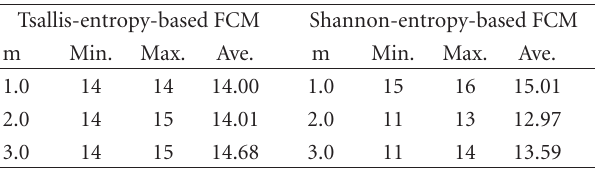
Table 1: Comparison of minimum, maximum, and average values of misclassified iris data (100